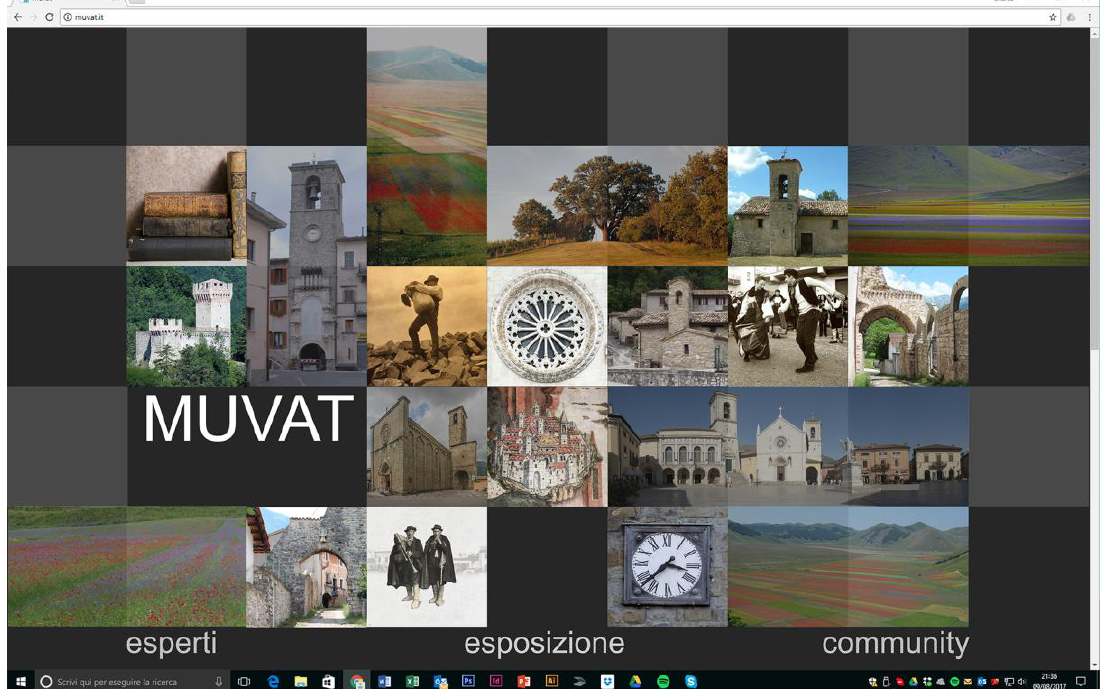
Figure 1. The home page of the MUVAT portal, where you can choose the type of navigation within the website: experts, exhibitions,